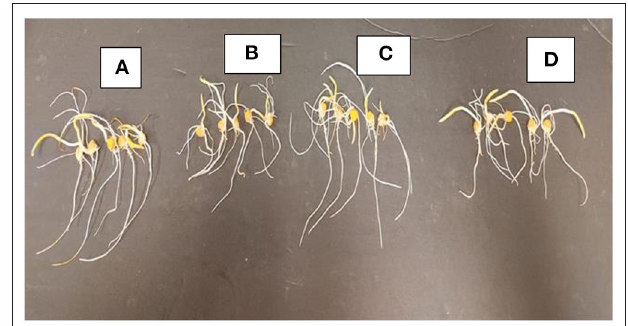
FIGURE 8 | Radicle length of corn with 0mM NaCl (A) , 50mM NaCl (B) , 50mM NaCl + 0.13% BA (C) , and 50mM NaCl + 0.13% M13 (D)